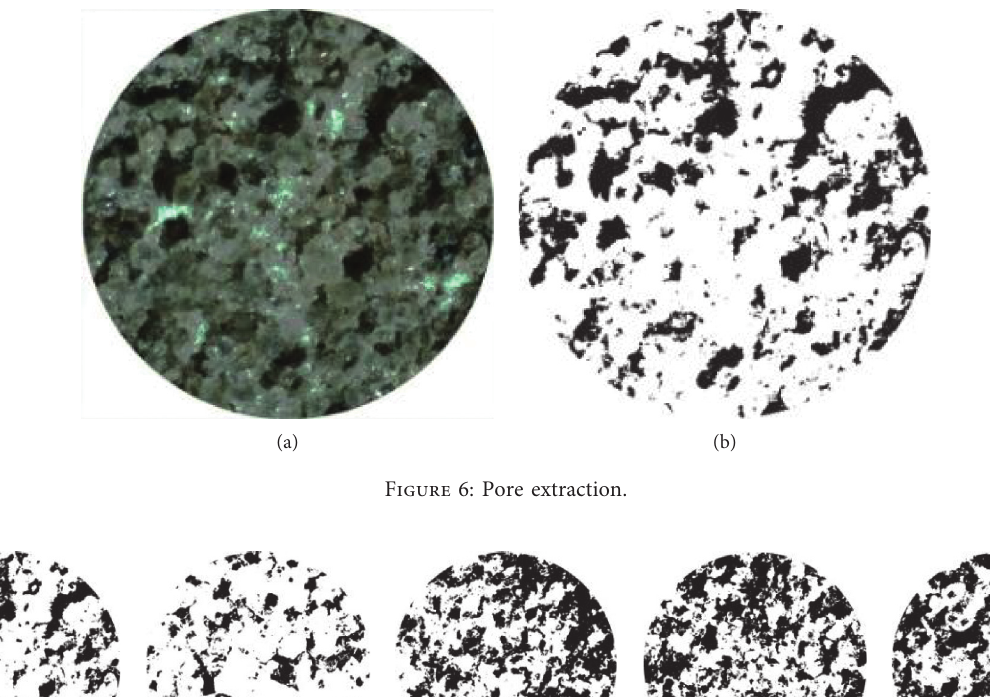
Figure 7: Microporosity change diagram of A zone in yellow sandstone under freeze-thaw cycles. (a) Freeze-thaw 0 times. (b) Freeze-thaw 5 times. (c) Freeze-thaw 10 times. (d) Freeze-thaw 20 times. (e) Freeze-thaw 40 times.